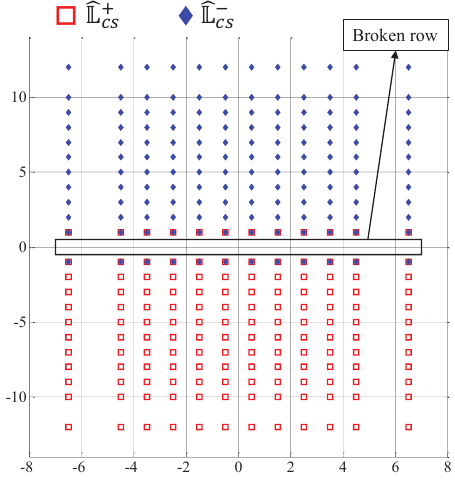
Figure 8. Broken row (or row of holes) appears between (cid:98) L cs and (cid:98) L − cs , when l = 8 > M 1 M 2 − ( M 2 − 1 ) ˘ M 1 − 1 =